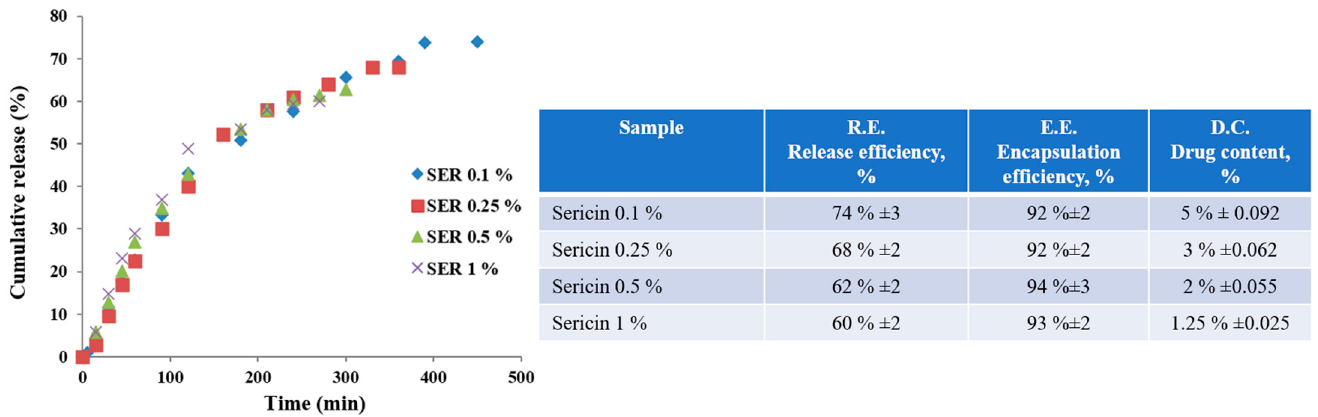
Figure 3. Doxorubicin release profile from sericin nanoparticles in neutral medium .